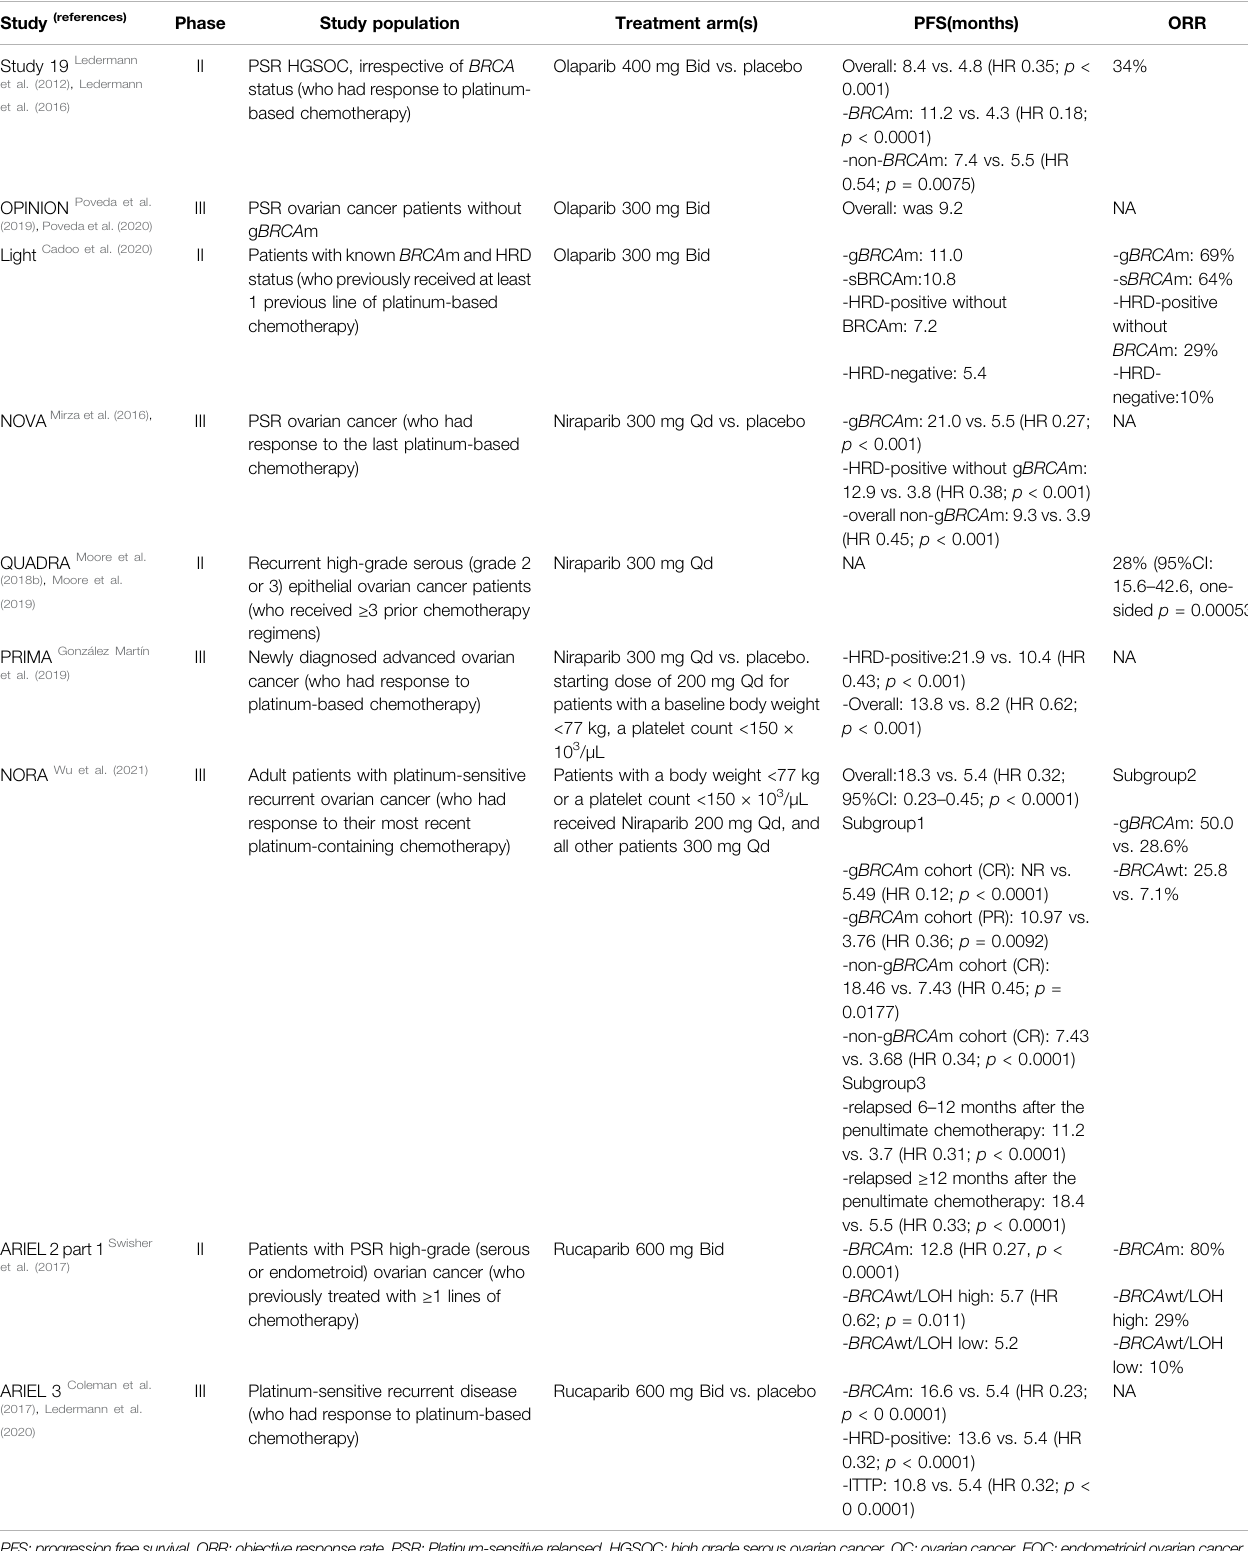
TABLE 2 | Published results for selected key studies of PARP inhibitors in Ovarian Cancer with non- BRCA